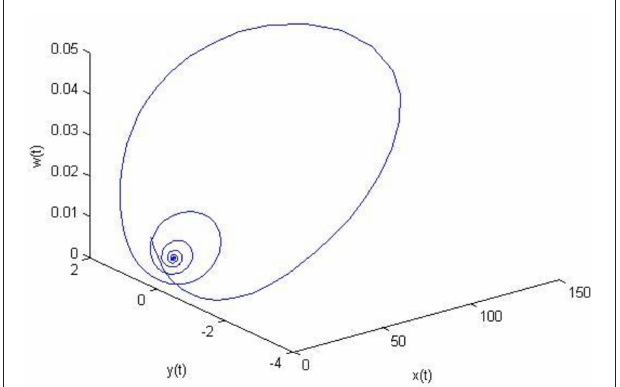
FIGURE 1 | System phase diagram.